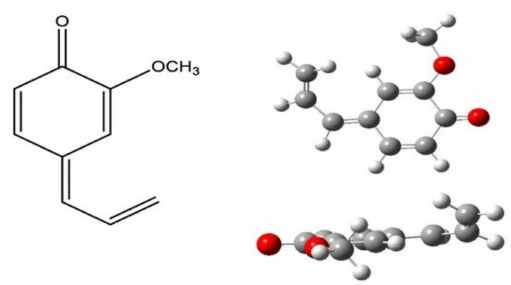
Figure 4. Derived quinone from eugenol after the donation of two hydrogen atoms following a step-wise hydrogen atom transfer (gas phase at B3LYP/6-31G); adopted from Figure 2 in